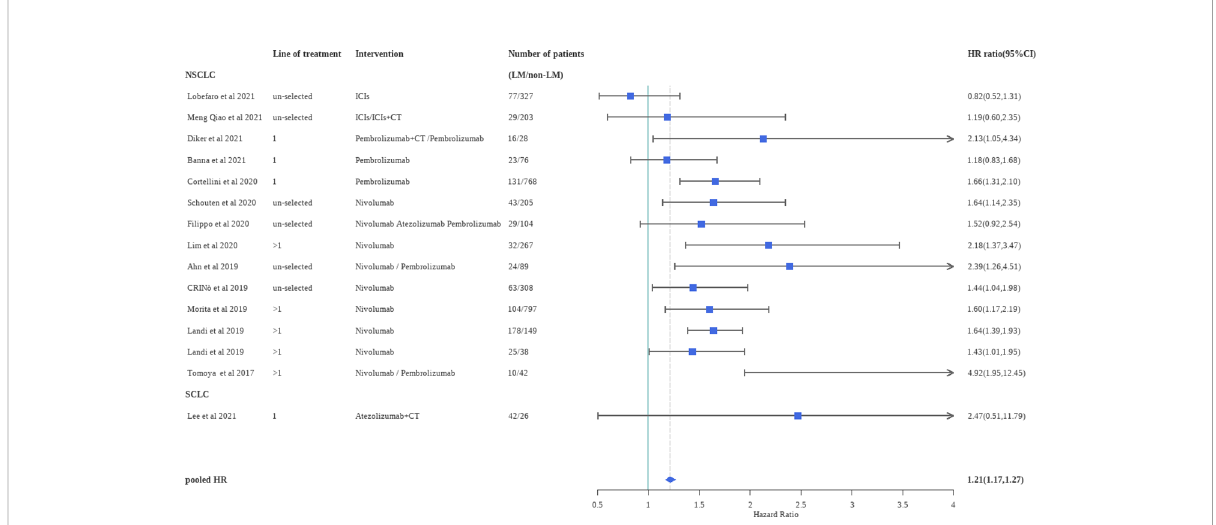
FIGURE 4 Forest plot of hazard ratios for OS according to liver metastases in clinical practice. ICIs, immune checkpoint inhibitors; CT, chemotherapy.